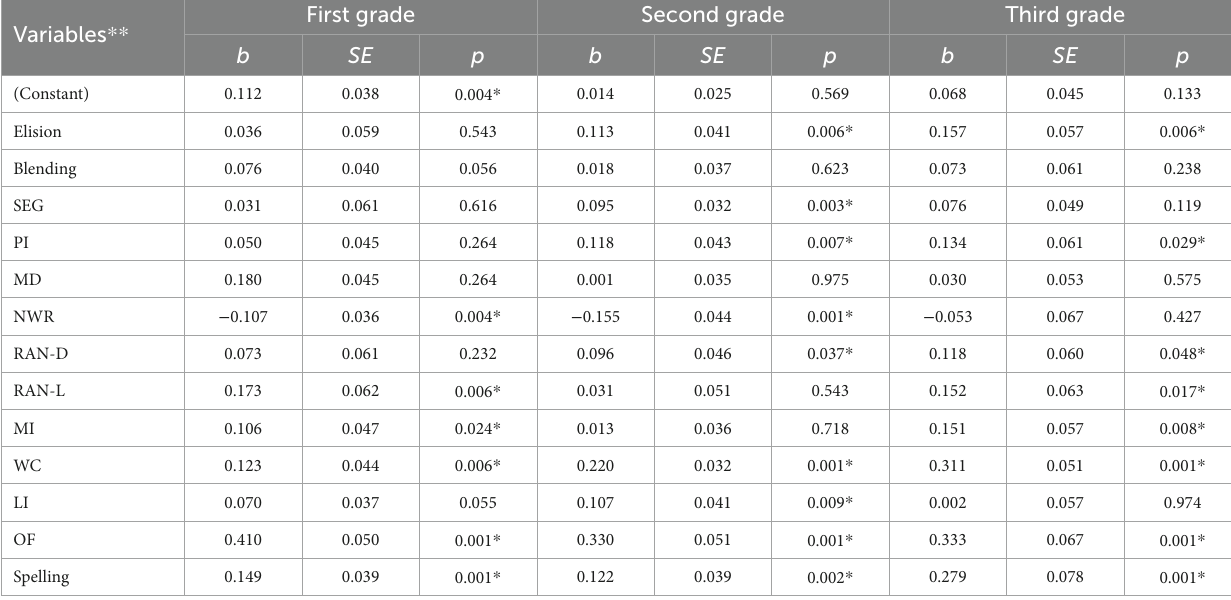
TABLE 8 Multiple regression results for individual subtest predictors of word reading fluency.